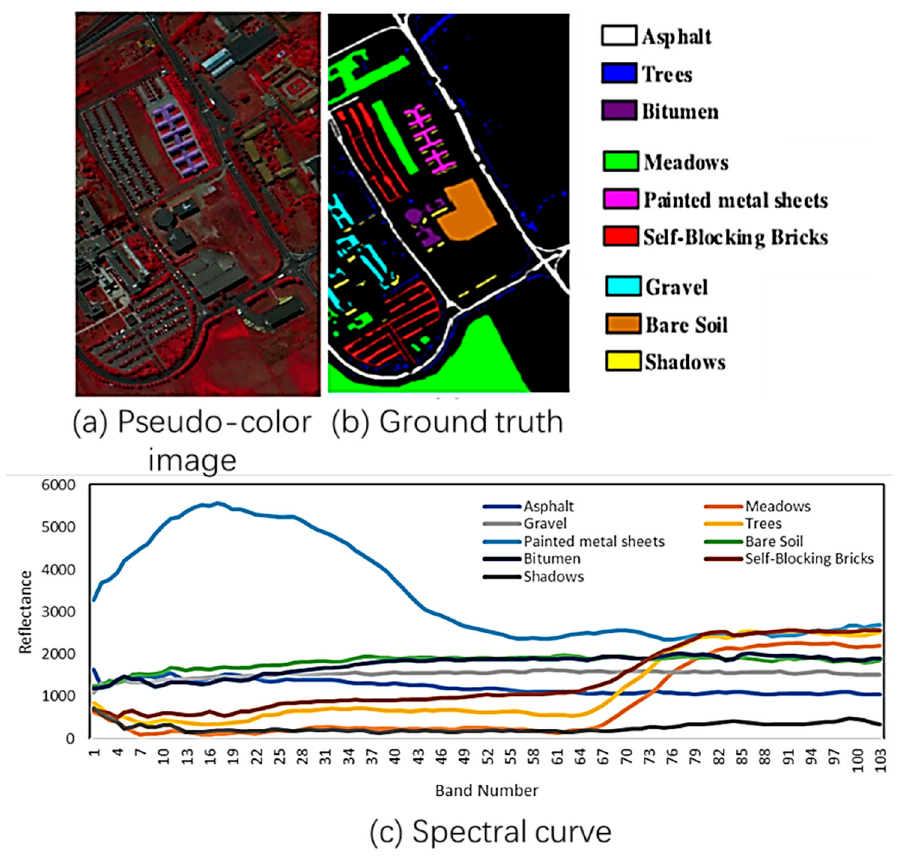
Figure 9. Pavia University dataset. ( a ) is pseudo-color image of Pavia University dataset. ( b ) is its Figure 9. Pavia University dataset. (a) is pseudo-color image of Pavia University dataset. (b) is its Figure 9. Pavia University dataset. (a) is pseudo-color image of Pavia University dataset. (b) is its Figure 9. Pavia University dataset. (a) is pseudo-color image of Pavia University dataset. (b) is its Figure 9. Pavia University dataset. (a) is pseudo-color image of Pavia University dataset. (b) is its ground truth image. ( c ) is the spectral curve of Pavia University dataset. Figure 9. Pavia University dataset. (a) is pseudo-color image of Pavia University dataset. (b) is its Figure 9. Pavia University dataset. (a) is pseudo-color image of Pavia University dataset. (b) is its ground truth image. (c) is the spectral curve of Pavia University dataset. ground truth image. (c) is the spectral curve of Pavia University dataset. Figure 9. Pavia University dataset. (a) is pseudo-color image of Pavia University dataset. (b) is its ground truth image. (c) is the spectral curve of Pavia University dataset. Figure 9. Pavia University dataset. (a) is pseudo-color image of Pavia University dataset. (b) is its ground truth image. (c) is the spectral curve of Pavia University dataset. Figure 9. Pavia University dataset. (a) is pseudo-color image of Pavia University dataset. (b) is its ground truth image. (c) is the spectral curve of Pavia University dataset. Figure 9. Pavia University dataset. (a) is pseudo-color image of Pavia University dataset. (b) is its ground truth image. (c) is the spectral curve of Pavia University dataset. ground truth image. (c) is the spectral curve of Pavia University dataset. ground truth image. (c) is the spectral curve of Pavia University dataset. ground truth image. (c) is the spectral curve of Pavia University dataset. ground truth image. (c) is the spectral curve of Pavia University dataset.